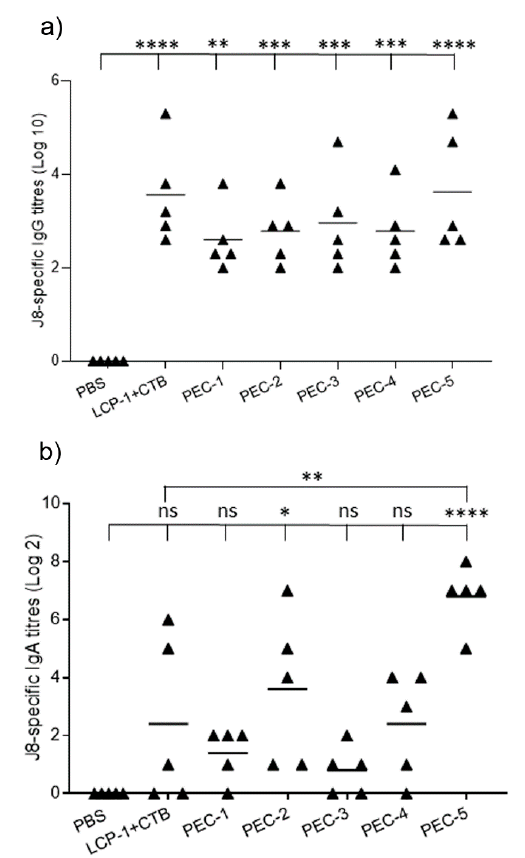
Figure 4. J8-specific serum IgG (a) and salivary IgA (b) titers in outbred Swiss mice models after second boost (experiment 2). ns, p > 0.05; * p < 0.05; ** p < 0.01; *** p < 0.001; **** p < 0.0001. PBS: phosphate buffer solution, CTB: cholera toxin B.